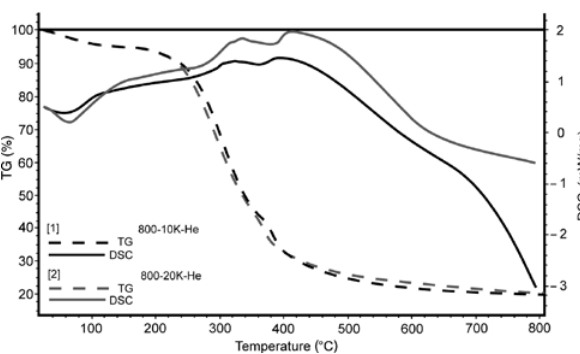
Figure 2: TG and